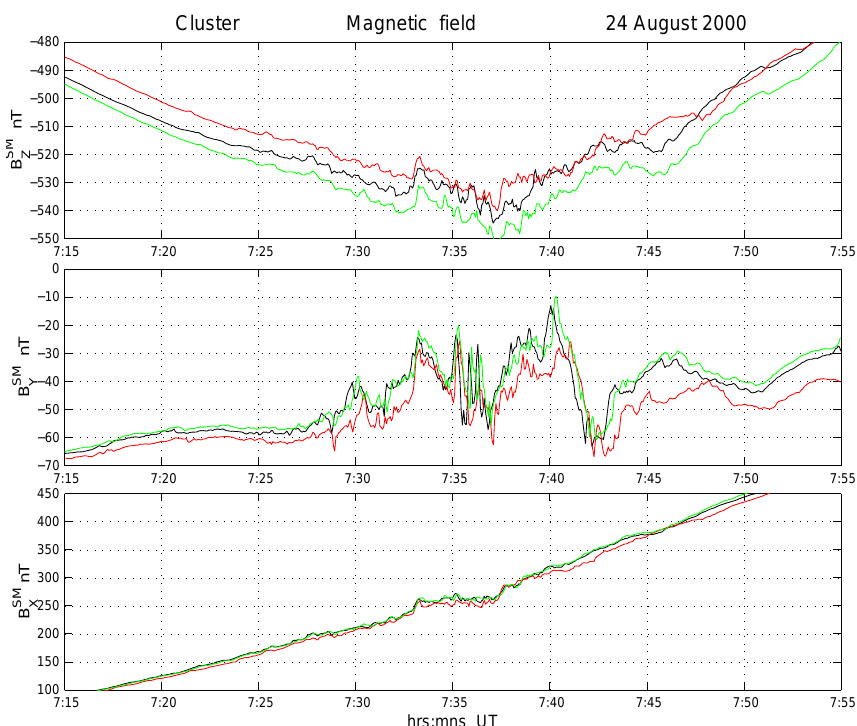
Fig. 4. The Z , Y and X magnetic field components in SM coordinates between 07:15 and 07:55UT on 24 August 2000. This corresponds to the region of field-aligned currents in the southern cusp.